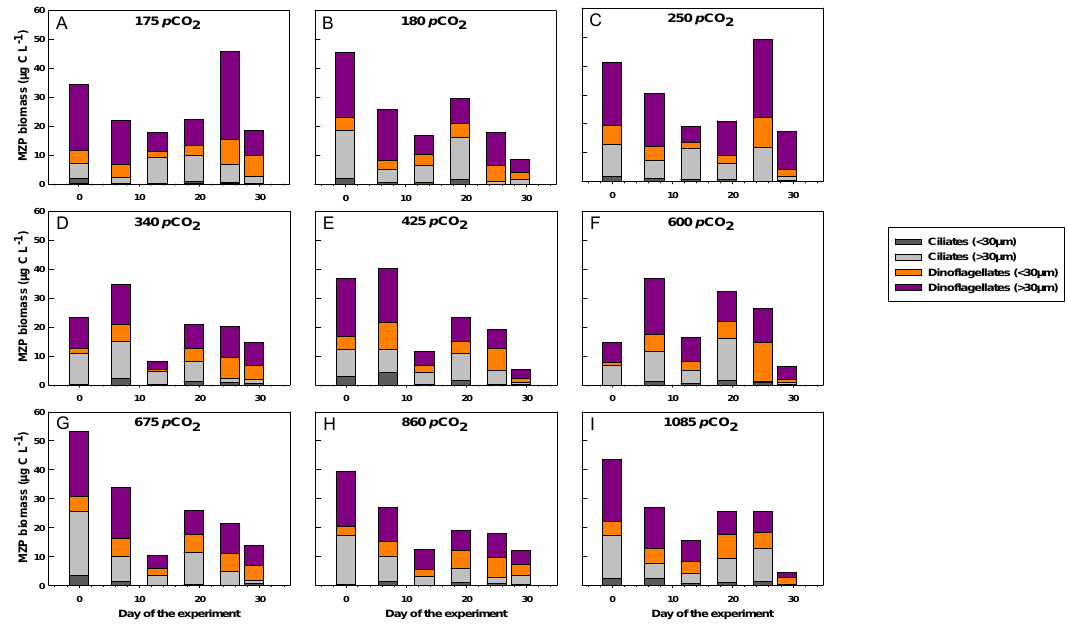
Fig. 3. Microzooplankton (MZP) biomass (µgCL − 1 ) (dark grey: ciliates < 30µm; light grey: ciliates > 30µm; orange: dinoflagellates Fig. 3: Microzooplankton (MZP) biomass (µg C L -1 ) (dark grey: ciliates <30µm; bright grey: ciliates >30µm; orange: dinoflagellates <30µm; purple: < 30µm; purple: dinoflagellates > 30µm) in the different p CO 2 treatments ( p CO 2 of 175 (A) , 180 (B) , 250 (C) , 340 (D) , 425 (E) , 600 (F) , dinoflagellates >30µm) in the different p CO 2 treatments ( p CO 2 of 175 (A), 180 (B), 250 (C), 340 (D), 425 (E), 600 (F), 675 (G), 860 (H) and 1085 675 (G) , 860 (H) and 1085 (I) (I)).